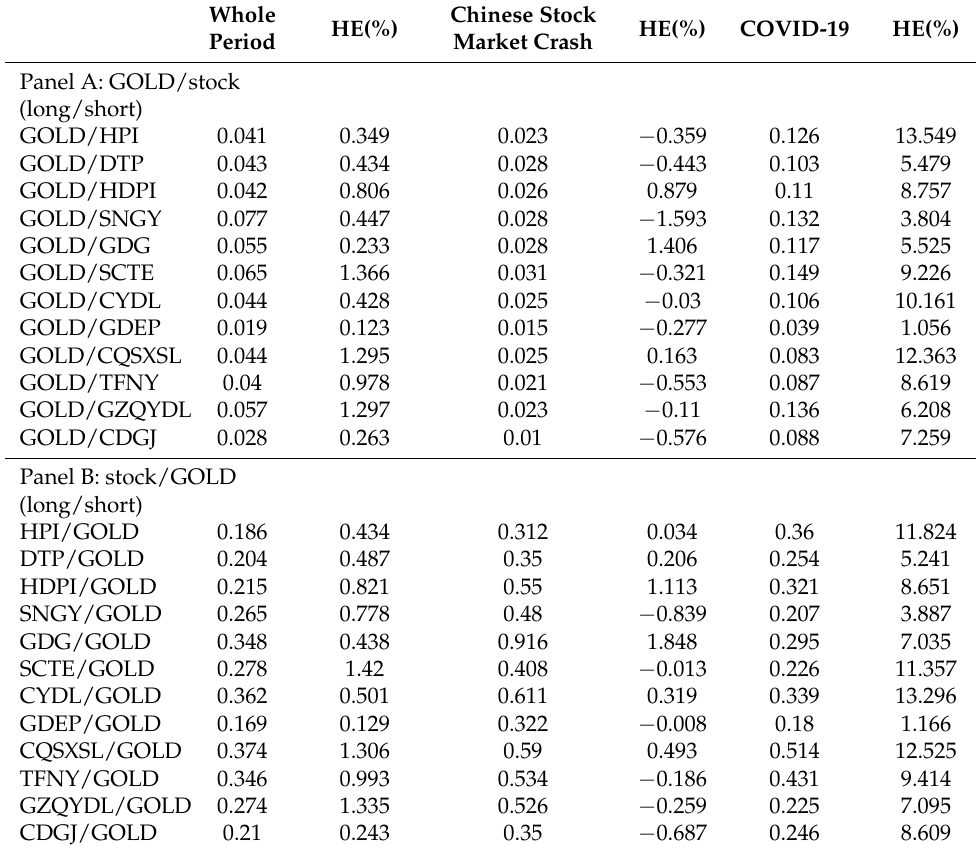
Table 5. Hedge ratios and the corresponding hedging effectiveness for gold and electricity